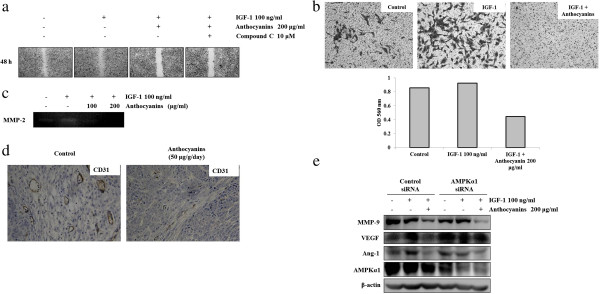
Anthocyanins inhibit cell invasion by regulating metastasis-related proteins in vivo and in vitro. (a) Hep3B cells were serum starved for 12 h and grown to confluence on a 6-well plate. Monolayers were wounded with a pipette tip, pretreated with IGF-1 (100 ng/ml) with or without Compound C for 30 min, and then treated with anthocyanins for 24 h. Images of wound closure were captured under a phase-contrast microscope after 24 h. (b) Hep3B cells were pretreated with IGF-1 (100 ng/ml) for 30 min, treated with anthocyanins for 24 h, and plated onto the apical side of Matrigel-coated filters in serum-free medium with or without IGF-1 and/or anthocyanins. Medium containing 2% FBS was placed in the basolateral chamber to act as a chemo-attractant. After 24 h, cells on the apical side were wiped off using a Q-tip, and cells that had migrated to the bottom of the filter were stained using crystal violet, and then photographed. (c) Cells were incubated with anthocyanins as described in (c) and Figure 
4c, medium was collected, and MMP-2 activity was measured by zymography. (d) Mice were sacrificed, tumor extracts were prepared, and immunohistochemical analysis was used to quantify CD31 expression (e) Hep3B cells were transiently transfected with AMPK siRNA or non-specific siRNA for 72 h, pretreated with IGF-1 (100 ng/ml) for 30 min, treated with anthocyanins (200 μg/ml) for 24 h, and then subjected to Western blot analysis using antibodies against MMP-9, VEGF, Ang-1, AMPK and β-actin (loading control).